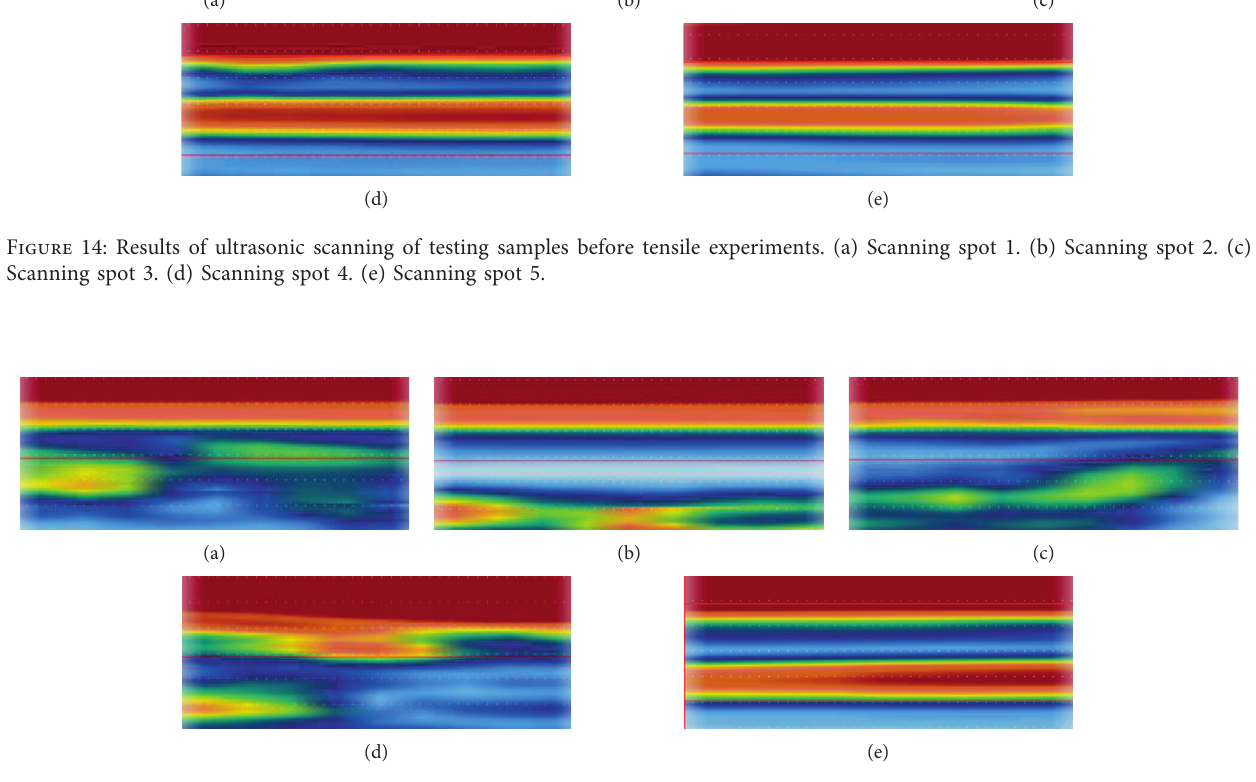
Figure 15: Results of ultrasonic scanning of testing samples after tensile experiments. (a) Scanning spot 1. (b) Scanning spot 2. (c) Scanning spot 3. (d) Scanning spot 4. (e) Scanning spot